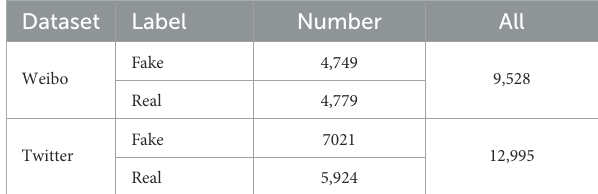
TABLE 1 The statistics of the real-world datasets includes Weibo dataset and Twitter dataset.